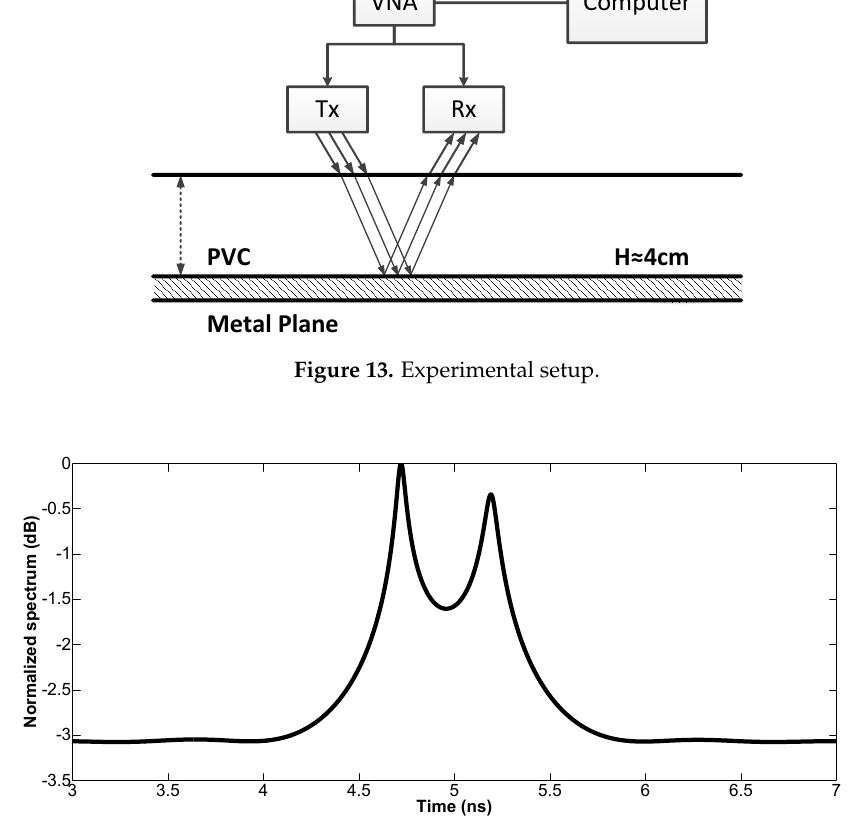
Figure 14. Pseudo-spectrum of MUSIC using the SSS technique with experimental